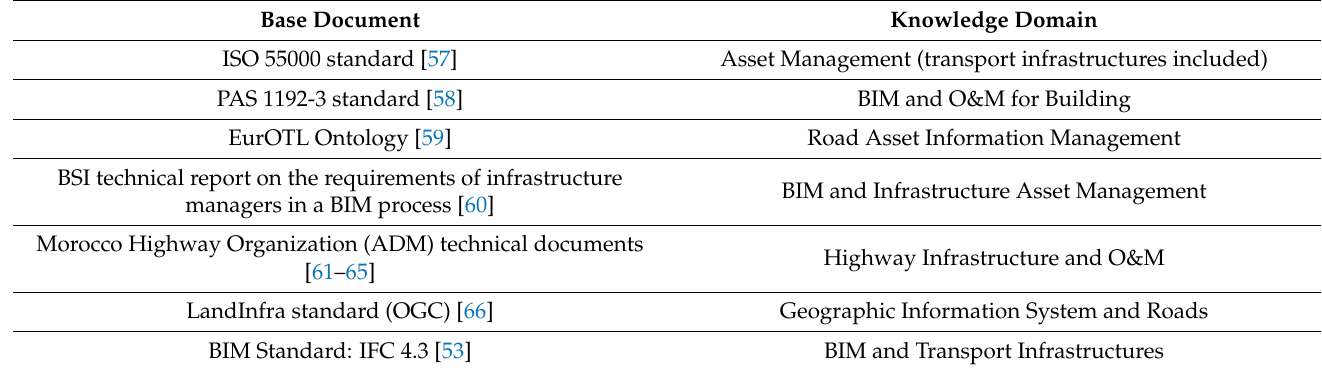
Table 3. Base Material for Constructing IFCInfra4OM